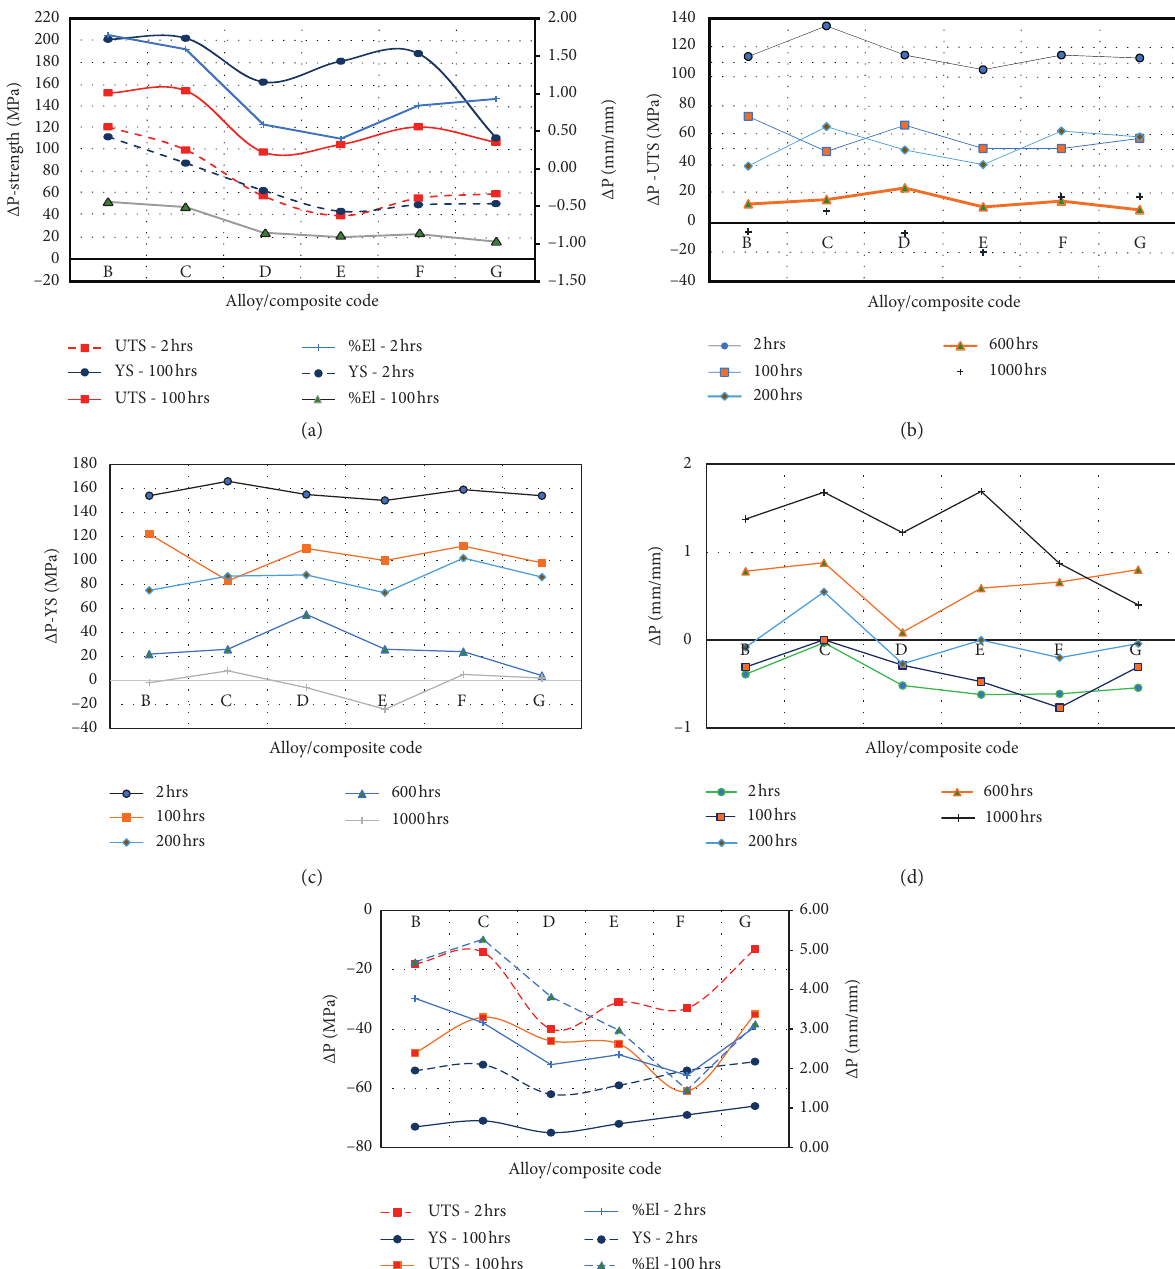
Figure 9: Variation in ∆ P as a function of aging condition: (a) 155 ° C, (b) UTS-190 ° C, (c) YS-190 ° C, (d) % El-190 ° C, and (e) 350 °